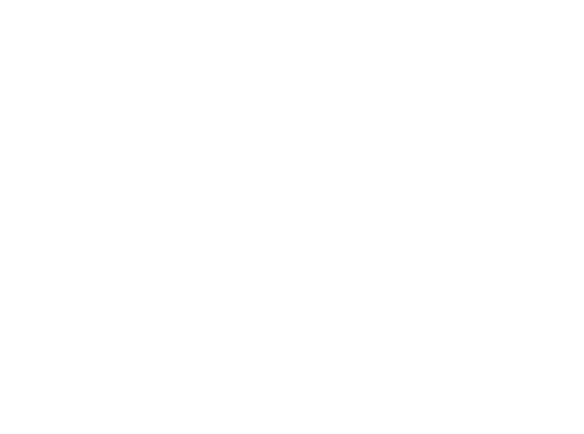
Figure 4. Effect of magnesium sulfate on serum corticosterone levels in rats exposed to chronic restraint stress (CRS). Administration of magnesium sulfate attenuated the increased serum corticosterone levels invoked by CRS [F (3, 20) = 30.08, p < 0.0001]. Values are expressed as the mean of 6 rats ± standard deviation (S.D.). Statistical analysis was applied using one-way ANOVA followed by Tukey’s post-hoc test. Significant differences versus control animals are denoted by * p < 0.05, or **** p < 0.001. Significant differences versus CRS group are denoted by # ### p < 0.001. CRS, chronic restraint stress; MgSO 4 , magnesium sulfate.